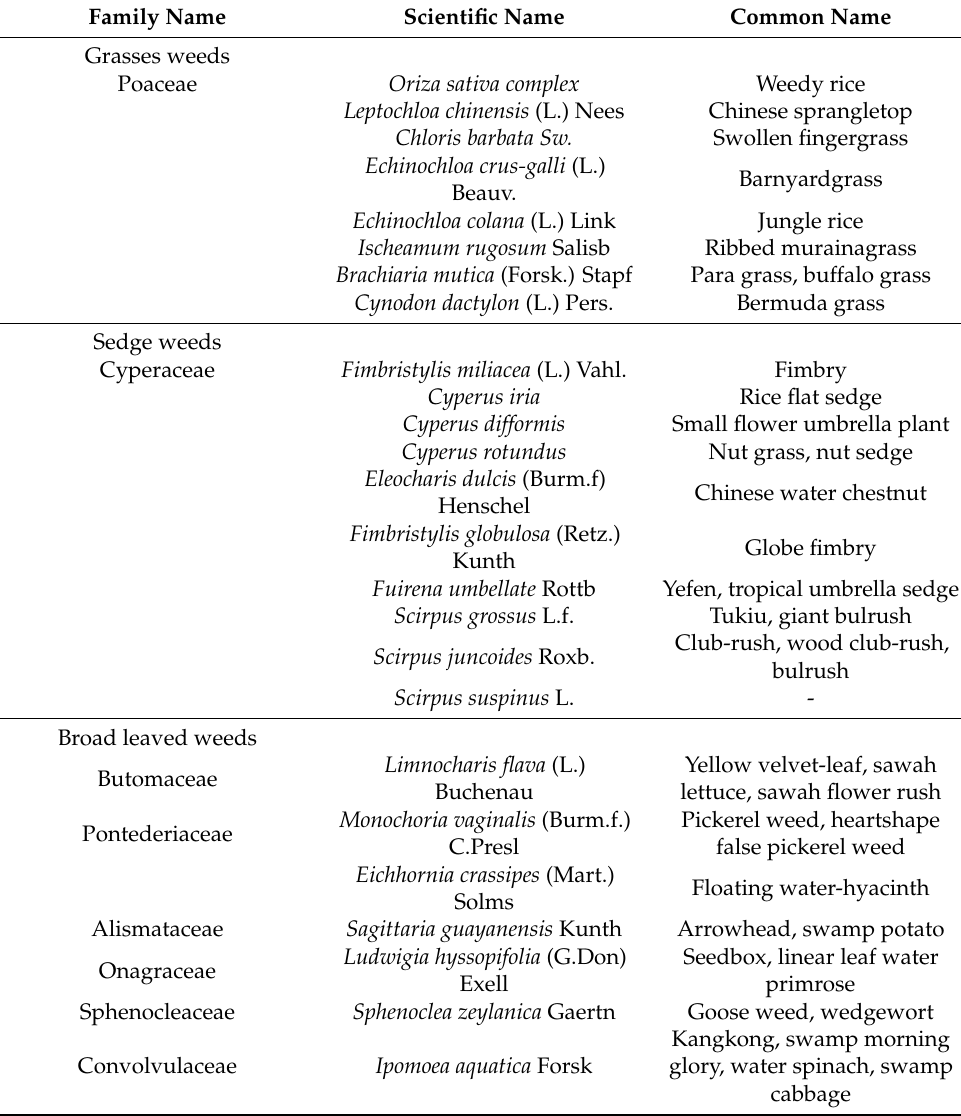
Table 1. Type of weeds commonly found in the paddy